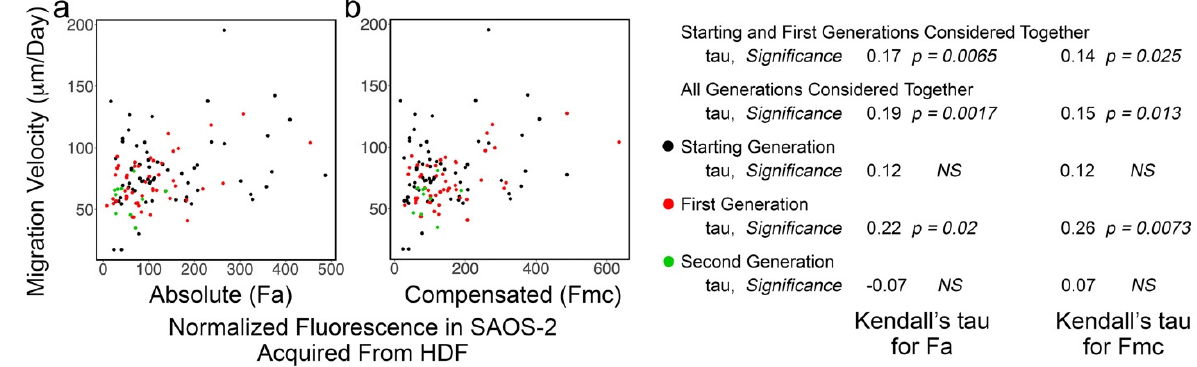
Figure 6. Scatter plots of experiment ‘f’ co-culturing SAOS-2 cells with HDFs, showing cell migration velocity of co-cultured SAOS-2 cells plotted against normalized fluorescence acquired from HDFs expressed as absolute fluorescence measured (Fa in panel a ), as well as numerical compensation for halving of fluorescence by cell division in mother cells (Fmc in panel b ). The generation to which each cell belonged is indicated by the colour. Values for Kendall’s tau of correlation and their statistical significance are shown for individual generations of cells, starting and first generations together and all generations of cells together. ( a ) There was weak correlation between cell migration and Fa. ( b ) This was decreased for Fmc. Table 3. Kendall’s tau of correlation between cell migration velocity of tracked SAOS-2 cells and absolute fluorescence acquired from co-cultured HDFs (Fa), as well as compensation for halving of fluorescence from mother cells by cell division (Fmc). Results from all experiments are shown. Results shown within individual experiments are from either all generations of cells together, starting and first generations together, or, where a second generation of cells was present, starting, first and second generations together. Selection of these within experiments was on the basis of the strongest statistical significance, while results for all grouped cell generations are shown in the Supplementary Materials, Table S10. Note that there were no statistically significant differences in experiments b and d and, here, selection was performed from starting and first generations considered together. Statistical significance is given, where NS indicates ‘not significant’ at p < 0.05. Where statistical significance was approached but not reached, the calculated p -value is given ( NS (p-value) ).